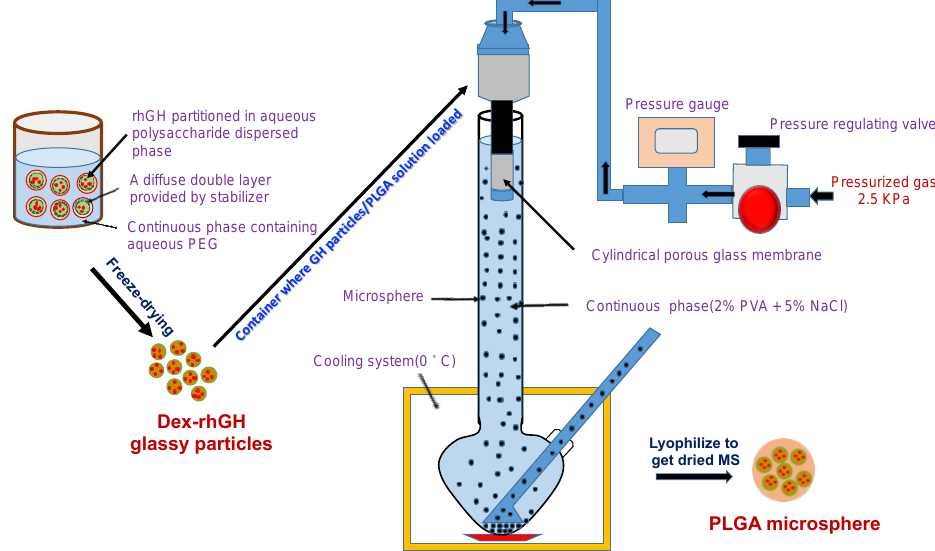
Figure 1. Schematic diagram of formulating dextran-recombinant human growth hormone (rhGH) micro particles loaded polylactic- co -glycolic acid (PLGA) microsphere.